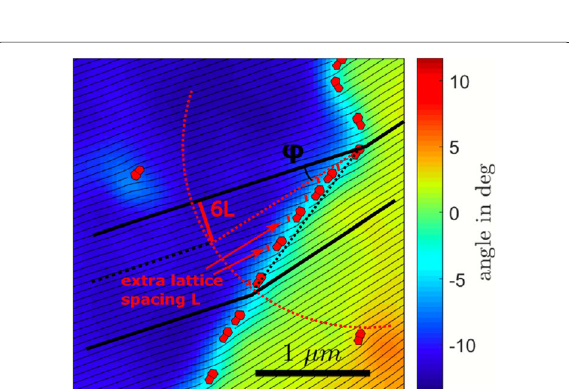
Fig. 4 Illustration of the lattice splitting by a string of defects. The six defects in the string each add a lattice spacing L , causing a lattice splitting at an angle